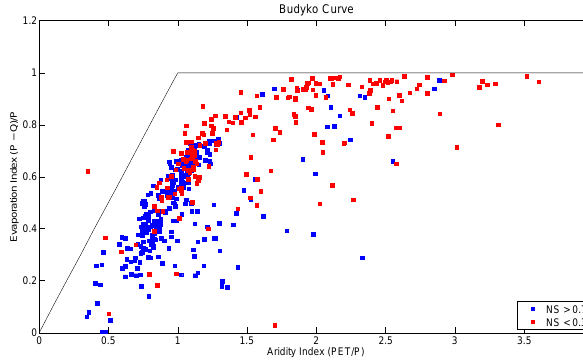
Fig. 5. Relationship of Nash Sutcliffe efficiency (NS) with gauge density around an ungauged catchment.